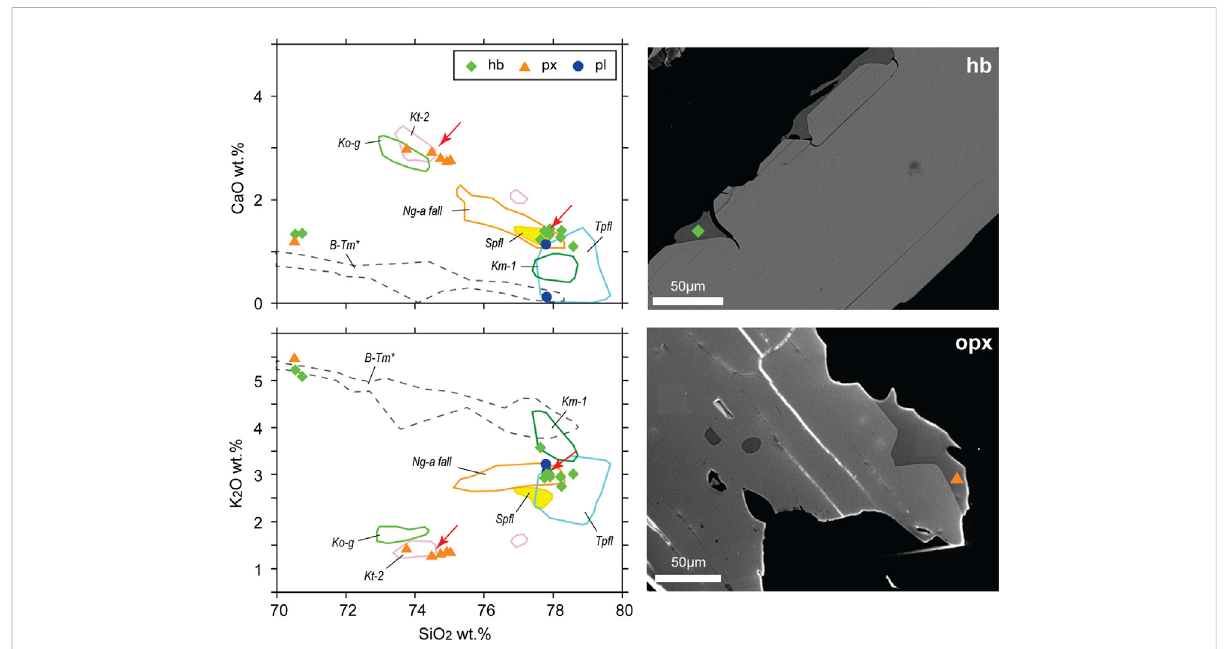
FIGURE 9 Chemicalcompositionsofglassattachedtocrystals,suchashornblende(hb),orthopyroxene(px),andplagioclase(pl)fromtheArutoriash(left). Representative BSE images of crystals with volcanic glass are shown in the right and the glass data of these images are shown by arrows in the left diagrams. Although some glasses plot in the fi eld of the Tp fl deposit and theNg-atephra, those associated with orthopyroxene are derived from the Kt-2 tephra (from Kuttara volcano). Glasses with high K 2 O contents also exist but the source volcano of these glasses is not